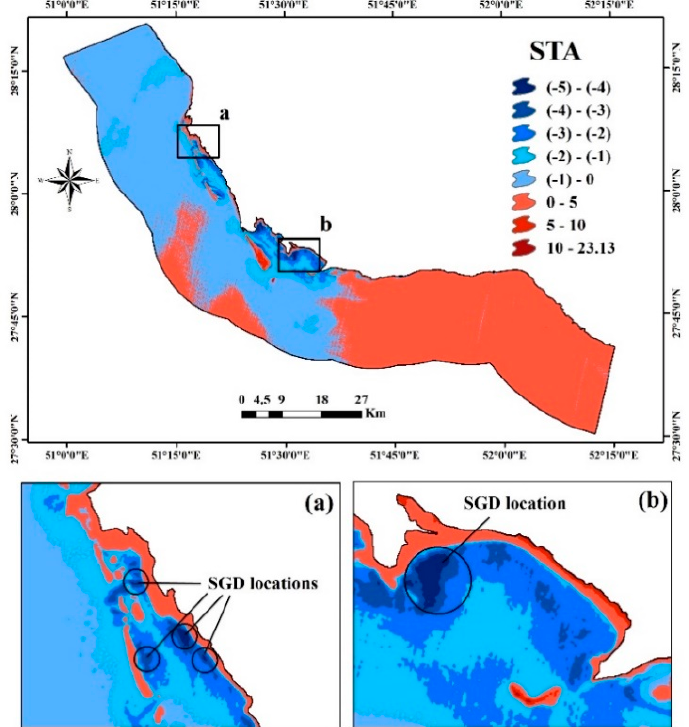
Figure 5. A reclassified STA map on 23 August 2015 and SGD location in the study area: ( a ) Shif-Hendijan and ( b ) Naiband #1. (negative temperature anomaly indicates SGD potential).